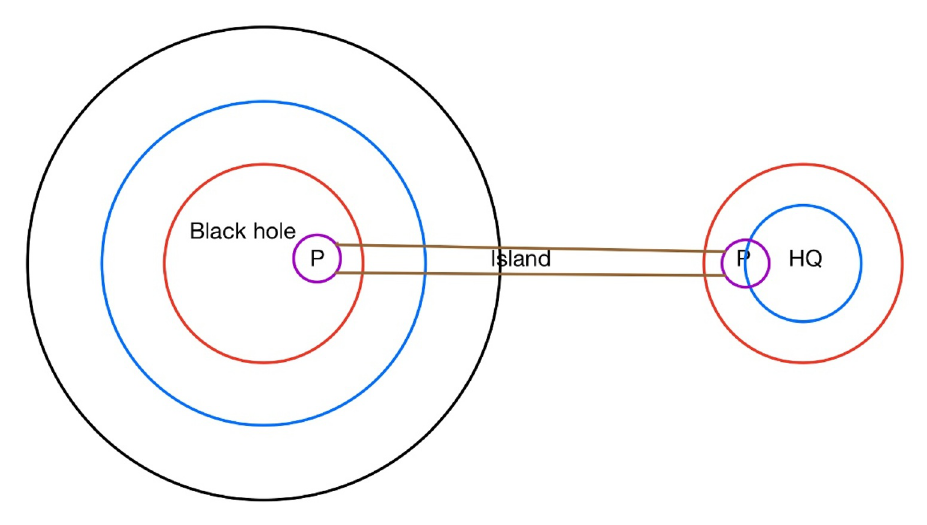
Figure 18. A representative figure of islands and purification: phase I: in the beginning phase, the black hole is the black sphere and there is no Hawking quanta. Phase II: evaporating black hole is blue sphere (l.h.s.) and HQ is blue sphere (r.h.s.). Phase III: (Page time) Red spheres in l.h.s.